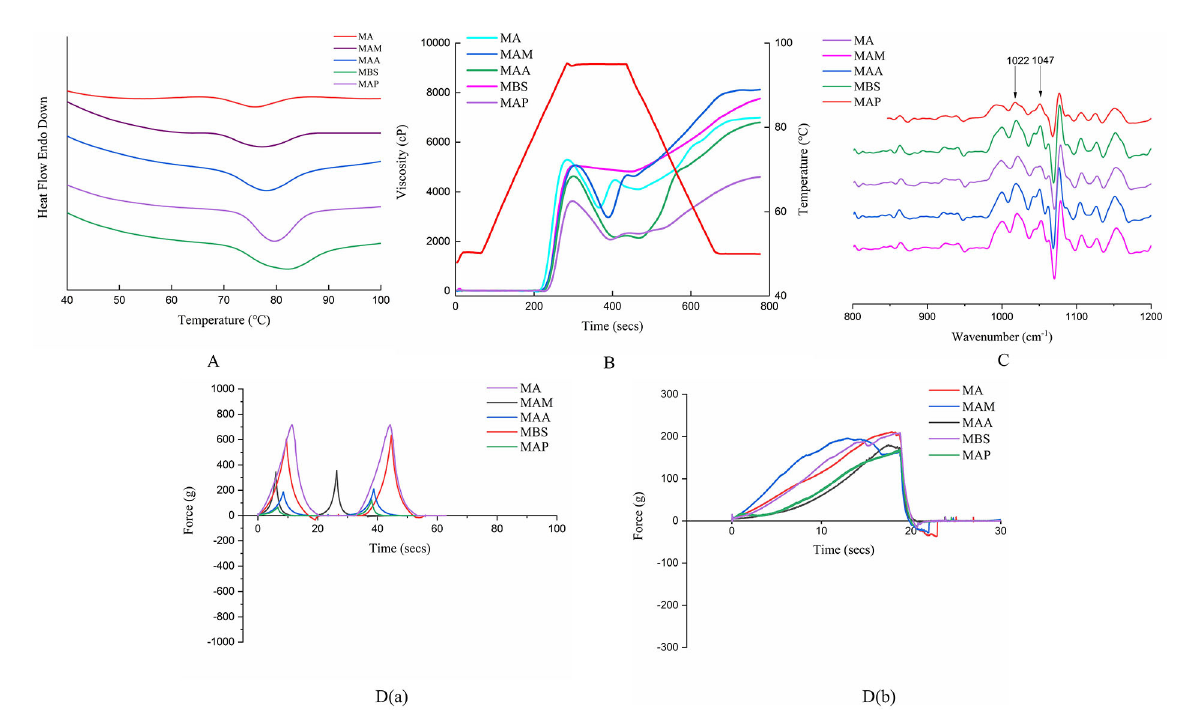
FIGURE3 Physicochemical property of starch from five Chinese banana species. (A) Thermodynamic characteristics of starch samples. (B) Pasting profiles of different kinds of starch. (C) Deconvoluted FTIR spectra of starch samples. (D) Textural properties of starch gels from starch samples. a. Occlusal dynamic curve of TPA pattern. b. Occlusal dynamic curve of gel 0.5